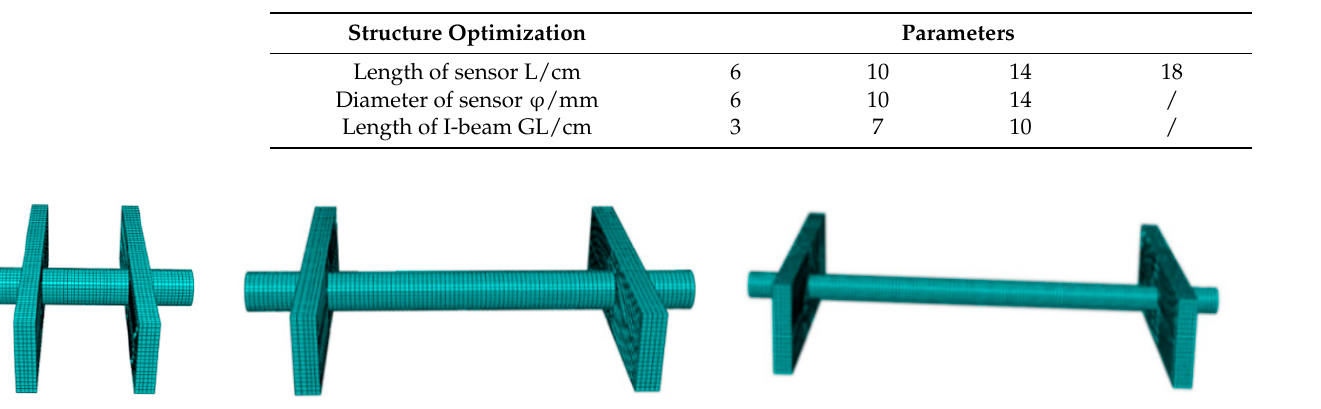
Table 1. I-shape sensing element structure optimization design parameters.